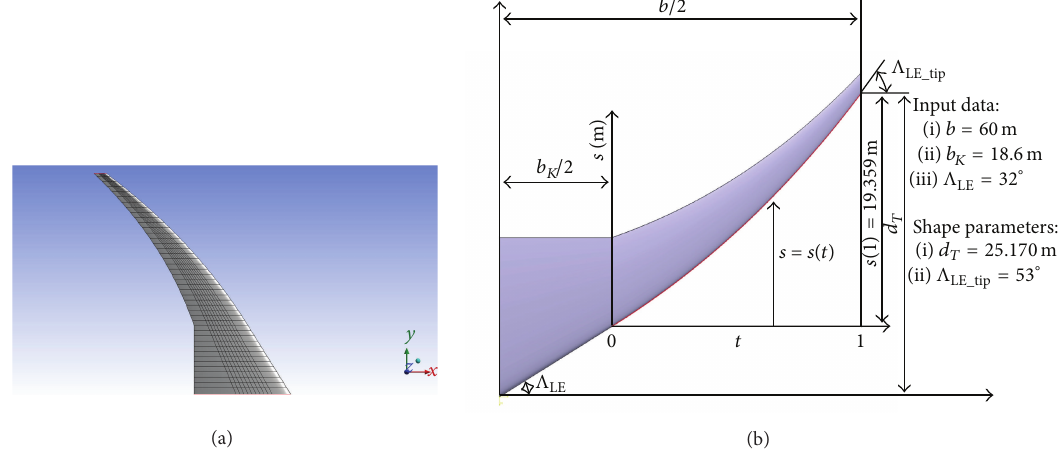
Figure 2: (a) Curved wing model. (b) Definition of leading edge geometry of the curved wing model.